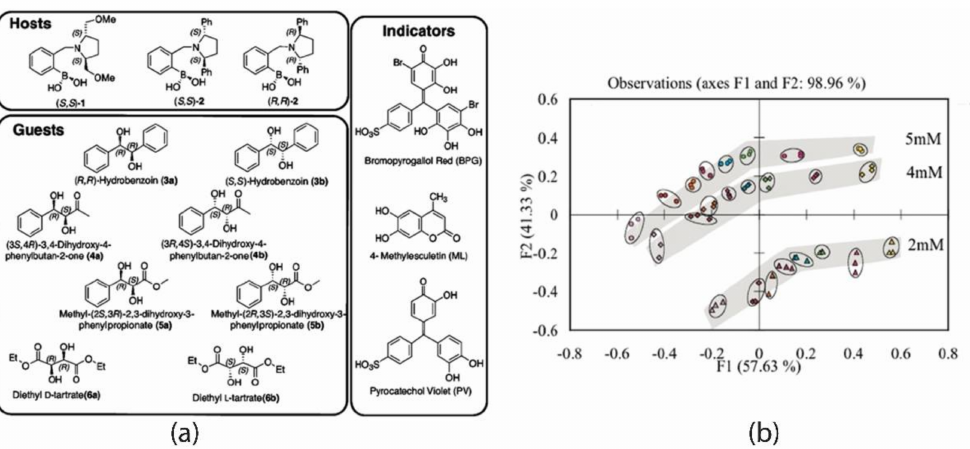
Figure 11. ( a ) Molecular structures of chiral hosts, indicators, and chiral diols screened by Anslyn and coworkers for the development of the colorimetric sensor array reported. ( b ) PCA of diol 5 ee titration at three different concentrations [2, 4, and 5 mM] for various ee ’s [ − 1 (yellow), − 0.6 (pink), − 0.2 (green), 0 (blue), 0.2 (red), 0.4 (orange), 0.6 (brown), and 1 (purple), where 1 is 100% 5a and − 1 is 100% 5b ]. Reprinted from Ref. [46] with permission from the American Chemical Society, copyright